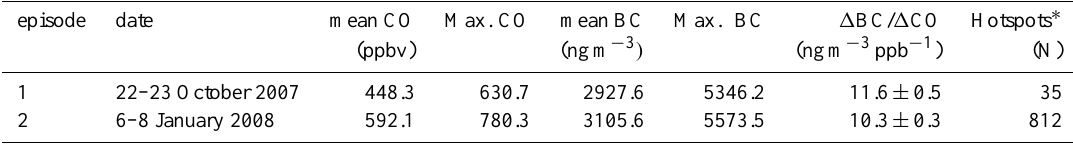
Table 2. The BC-CO relationships in BB pollution dominant